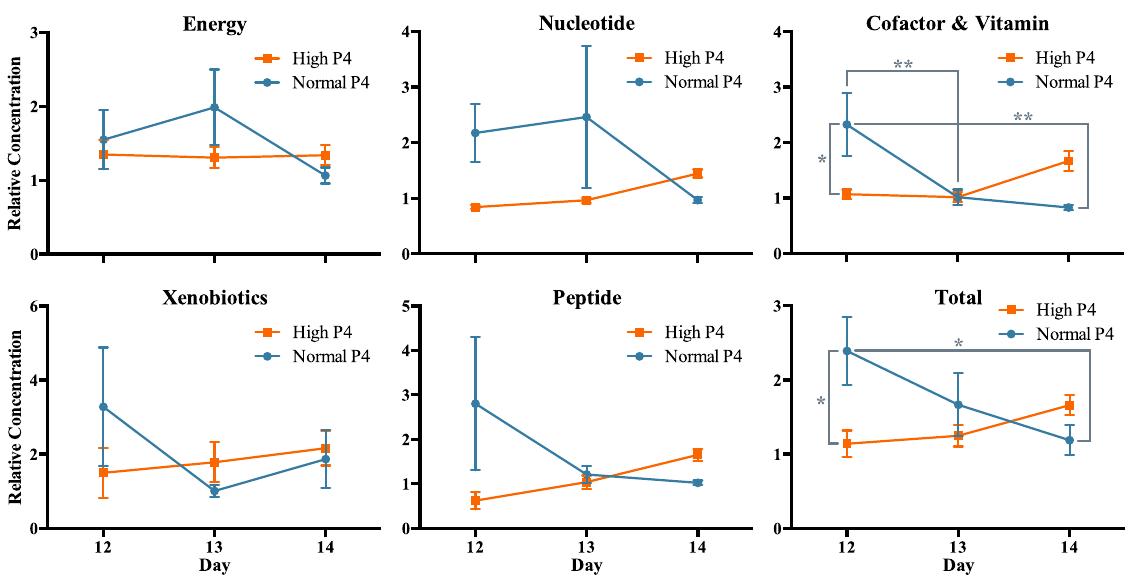
Figure 4. Relative concentrations ( ± SEM) of energy (n = 11), nucleotide (n = 19), cofactor and vitamin (n = 12), xenobiotic (n = 15), and peptide (n = 2) metabolites in the uterine luminal fluid of high and normal progesterone (P4) animals on Days 12, 13, and 14, wherein ** represents p ≤ 0.001 and * represents p ≤ 0.05 – as determined by two-way analysis of variance coupled with a Holm-Sidak non-parametric post hoc